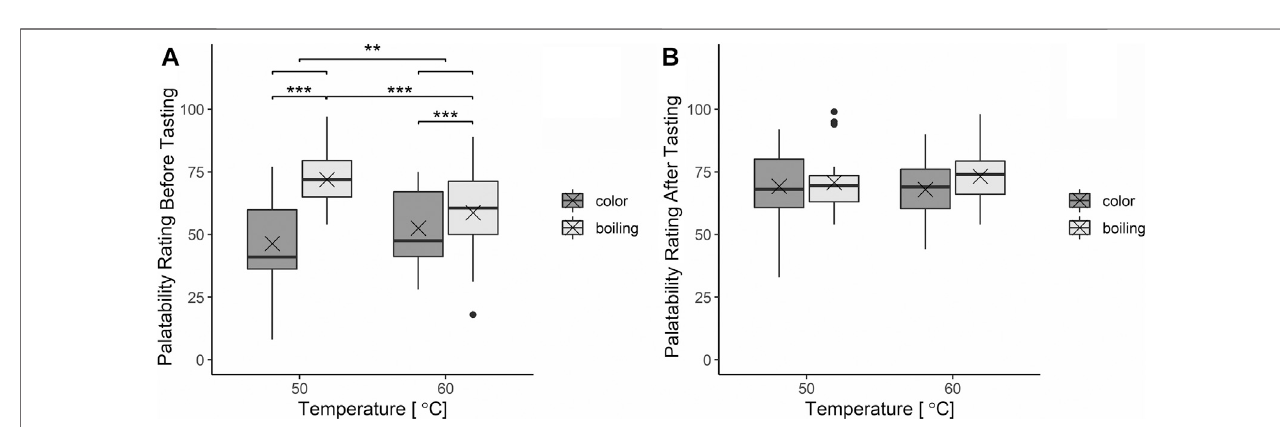
FIGURE 6 | (A) Palatability ratings before tasting and (B) after